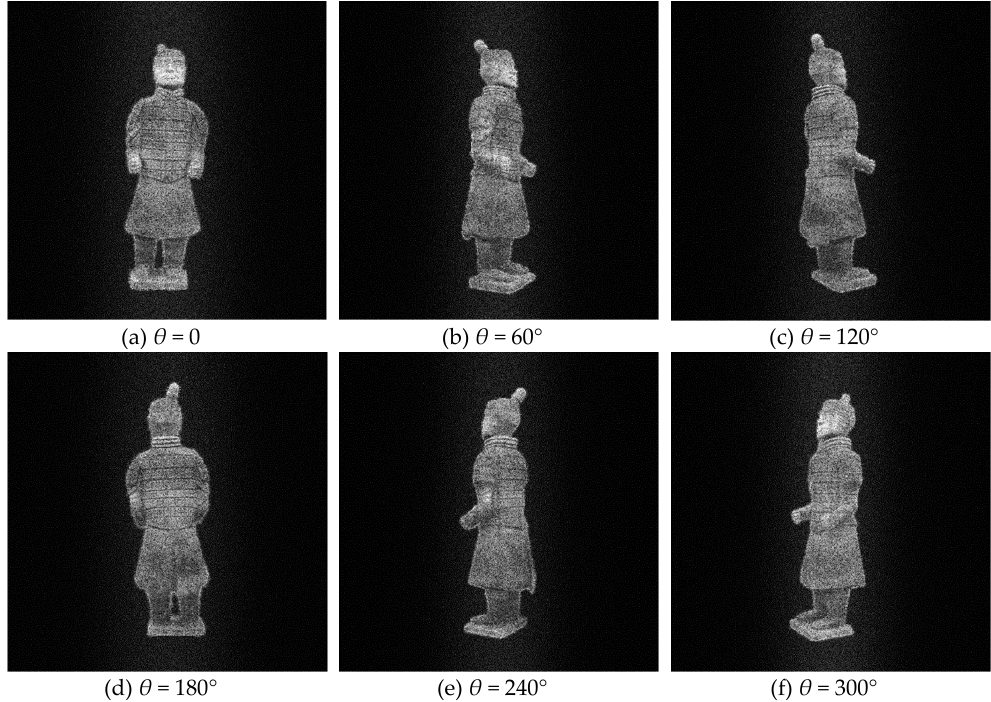
Figure 4. Original 3D images viewed at different angles.